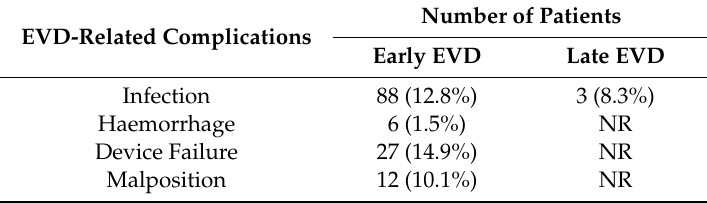
Table 5. EVD-related complication rates by the time of the EVD